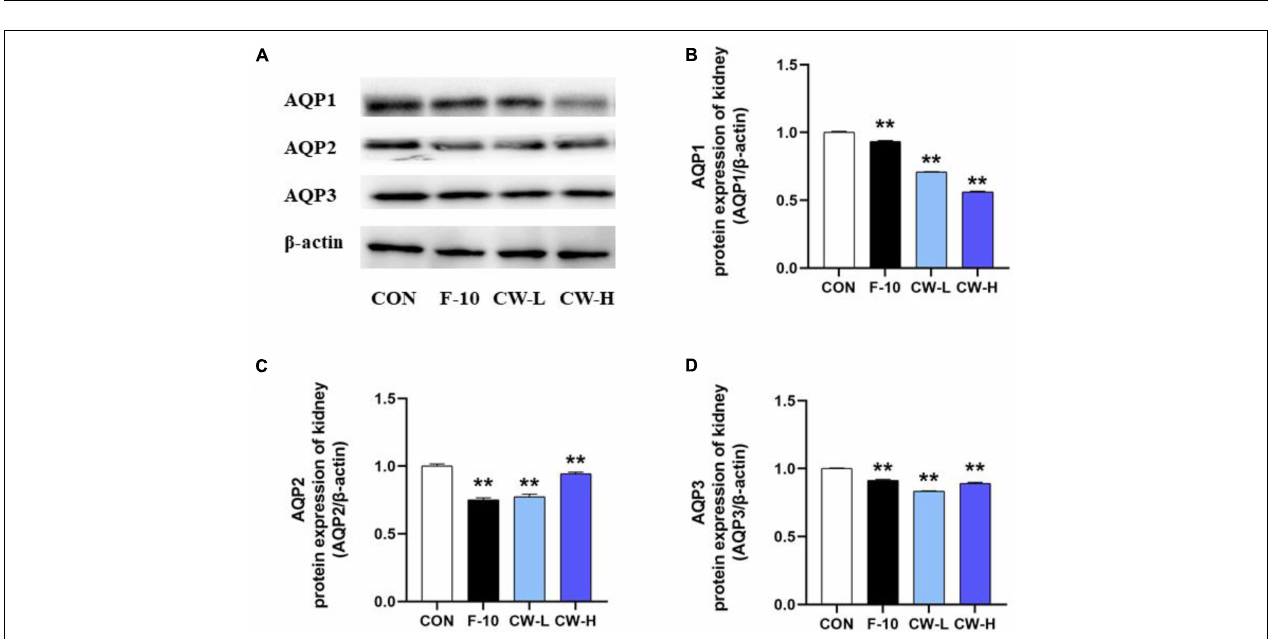
FIGURE 3 | Effect of prolonged coconut water treatment on rat serum levels of aquaporin 1 (AQP1) (A) , AQP2 (B) , and AQP3 (C) and the mRNA expressions of AQP1, AQP2, and AQP3 in the kidney. The mRNA levels of AQP1, AQP2, and AQP3 were detected by RT-PCR. The mRNA levels of AQP1 (D) , AQP2 (E) , and AQP3 (F) were normalized to the model. Values are expressed as mean ± SD ( n = 9), * p < 0.05 and ** p < 0.01 compared to the control group.